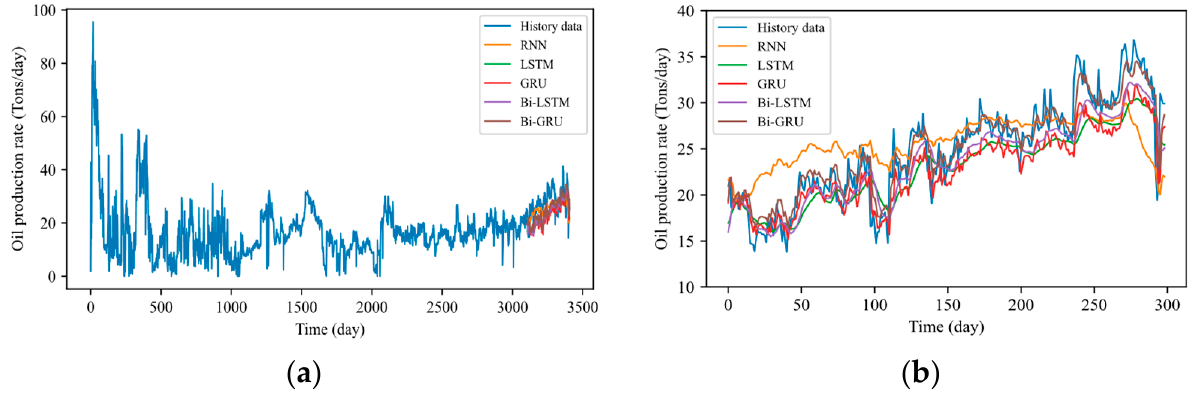
Figure 7. Comparison of prediction results of the five models: ( a ) history data and prediction results; ( b ) prediction results.